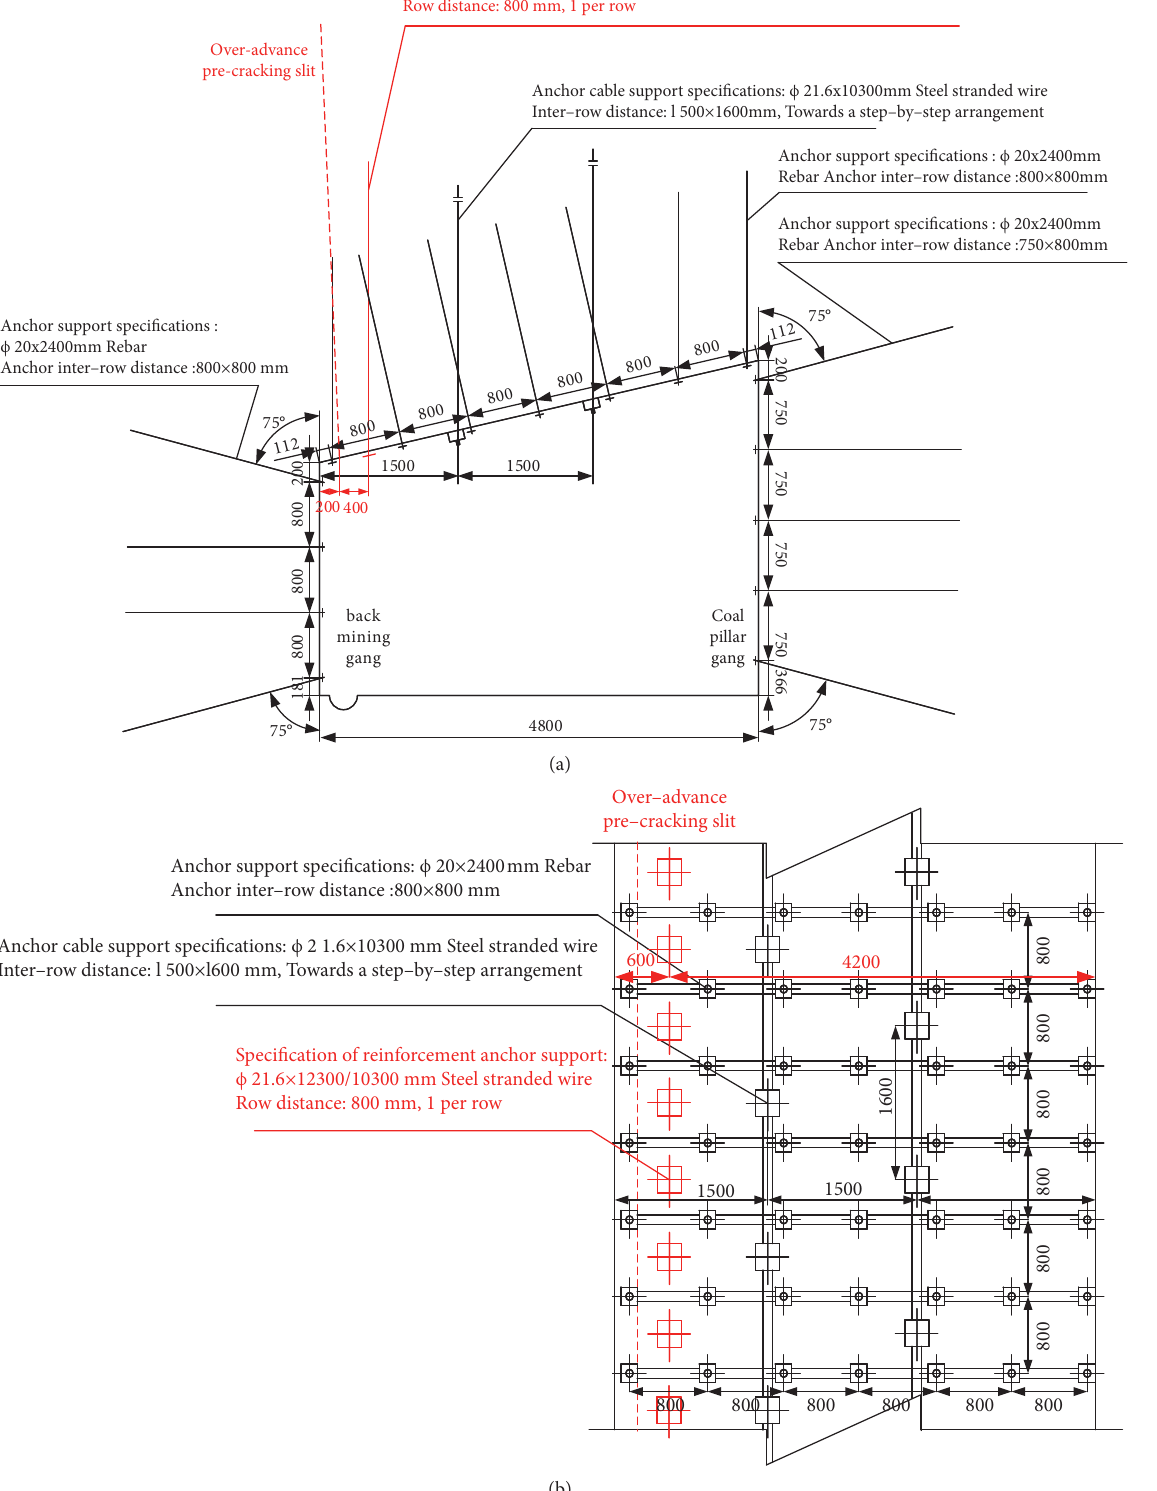
Figure 9: Section and plan of roof reinforcement and